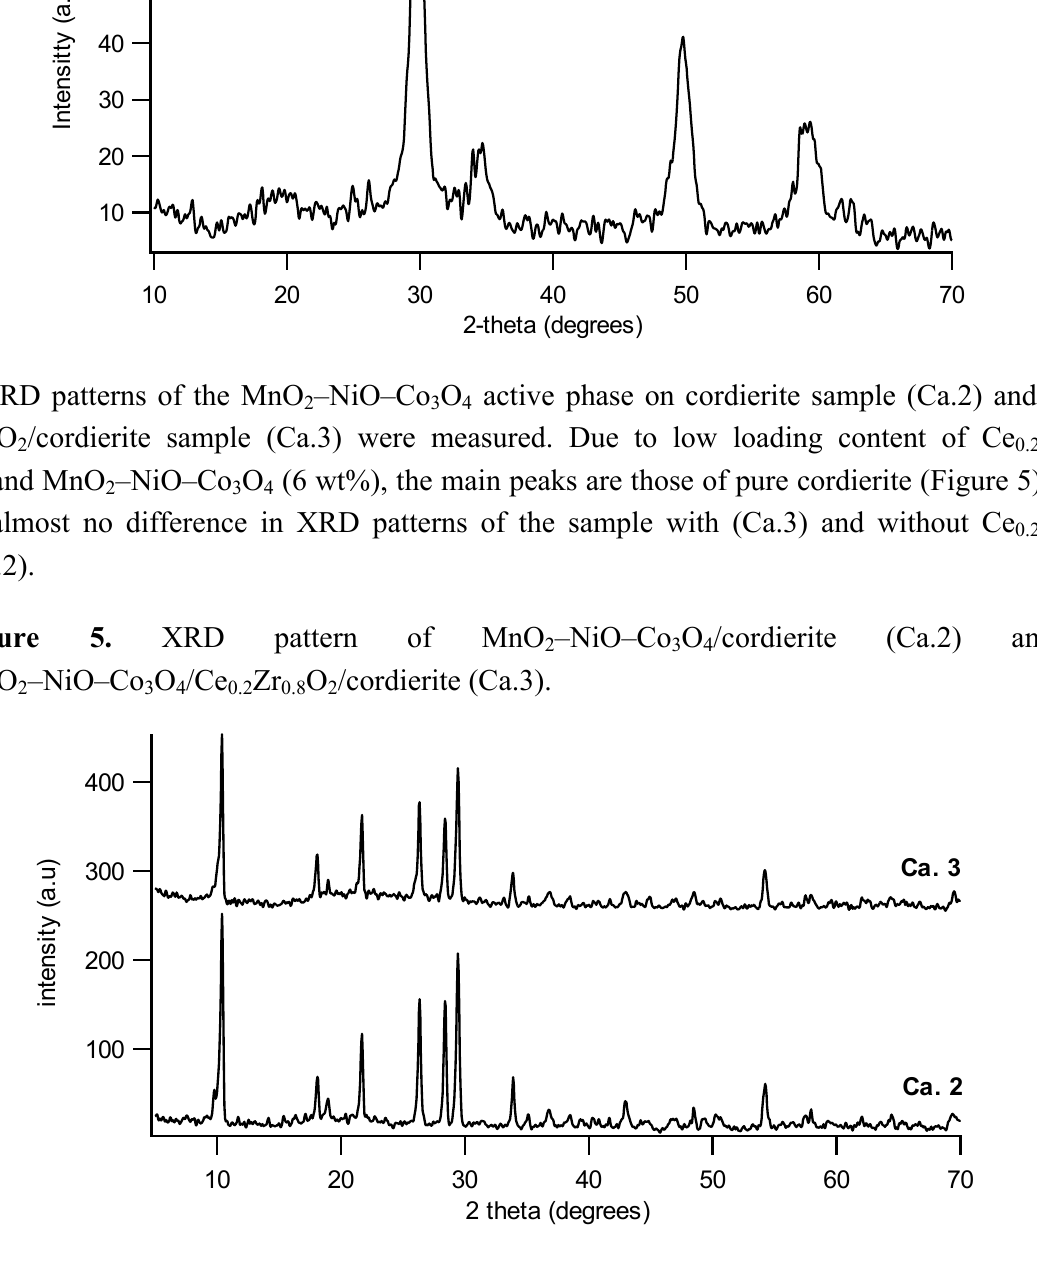
Zr O powder obtained by the same synthesis procedure as 0.2 0.8 2